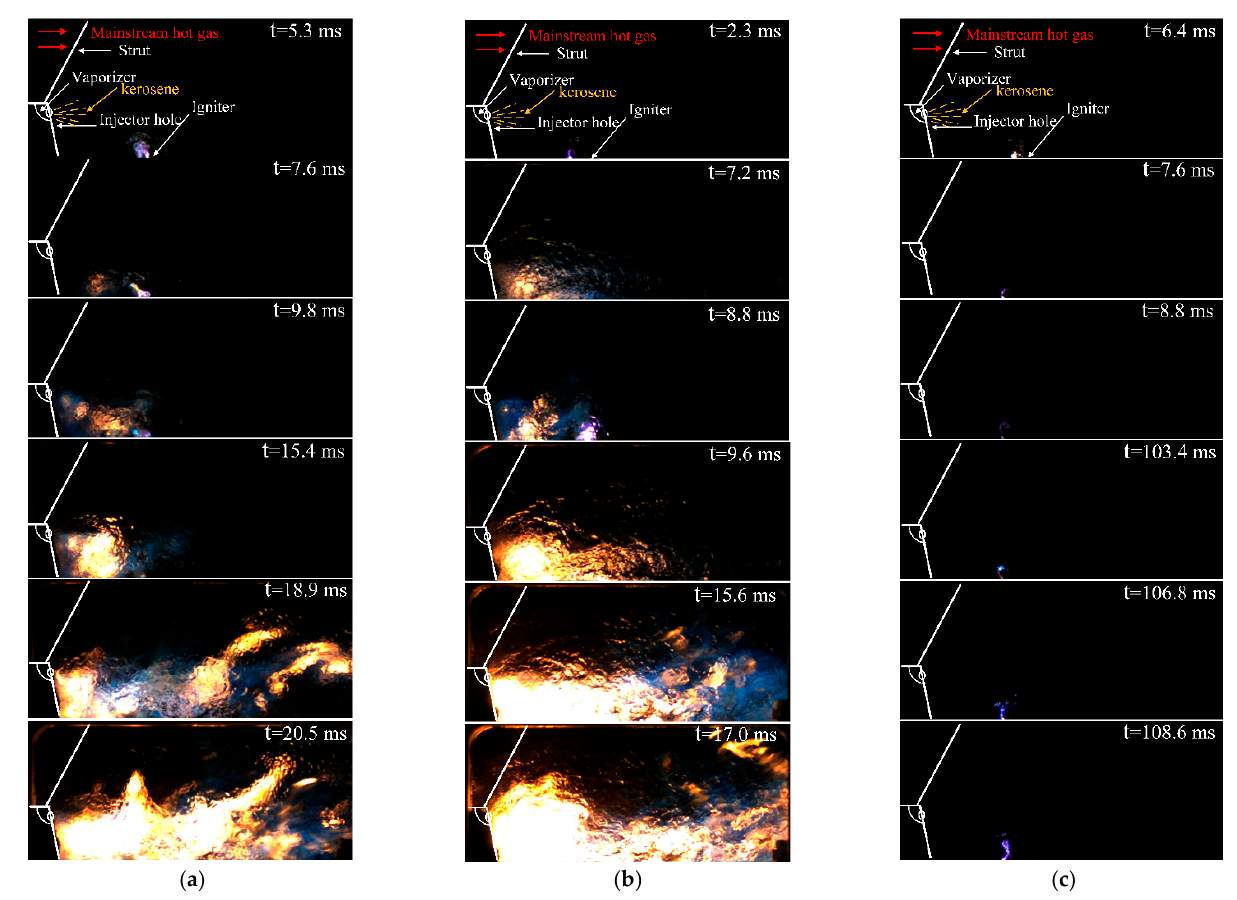
Figure 15. Ignition process at different ∆ p values: ( a ) ∆ p = 50 Torr; ( b ) ∆ p = 350 Torr; ( c ) ∆ p = 550 Torr.